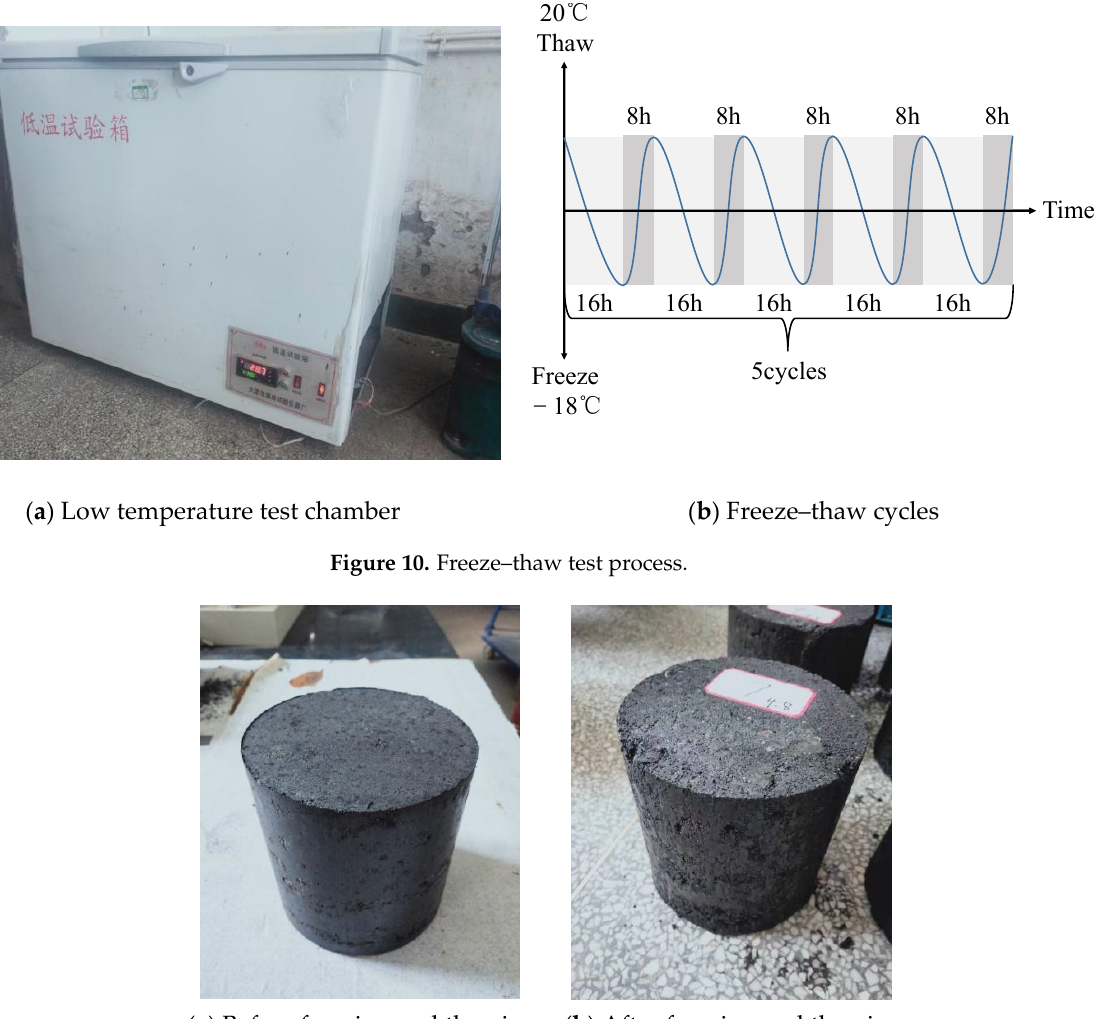
Figure 11. Freeze–thaw test.